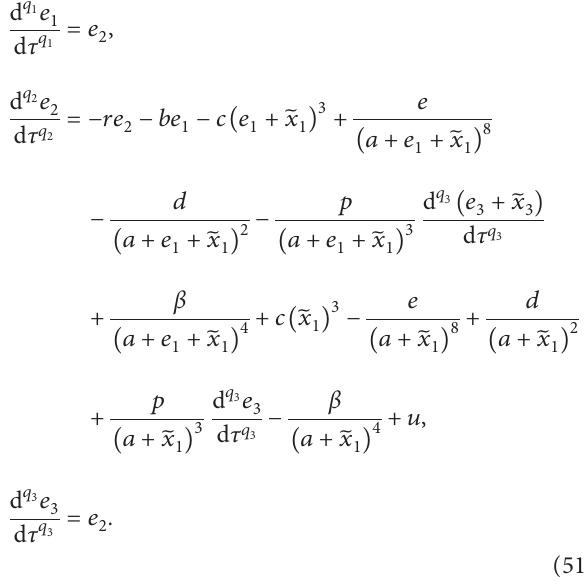
� x − 􏽥 x � x − 􏽥 x and e , by considering q 1 1 1 2 2 2